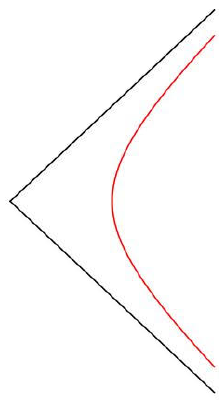
Figure 3 . Cartoon of a Rindler wedge, showing both the (red) hyperbolic world-line of an accel- erating observer and the (black) horizons to which it